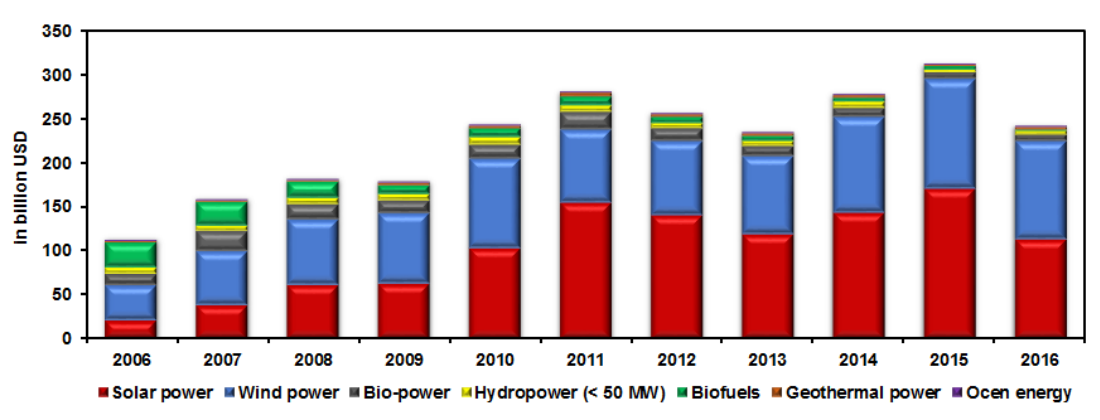
Figure 1. Breakdown of new investment by technology. Adapted from [9].